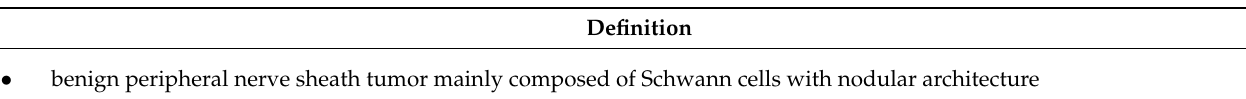
Table 3. Key diagnostic features of isolated cutaneous/nodular